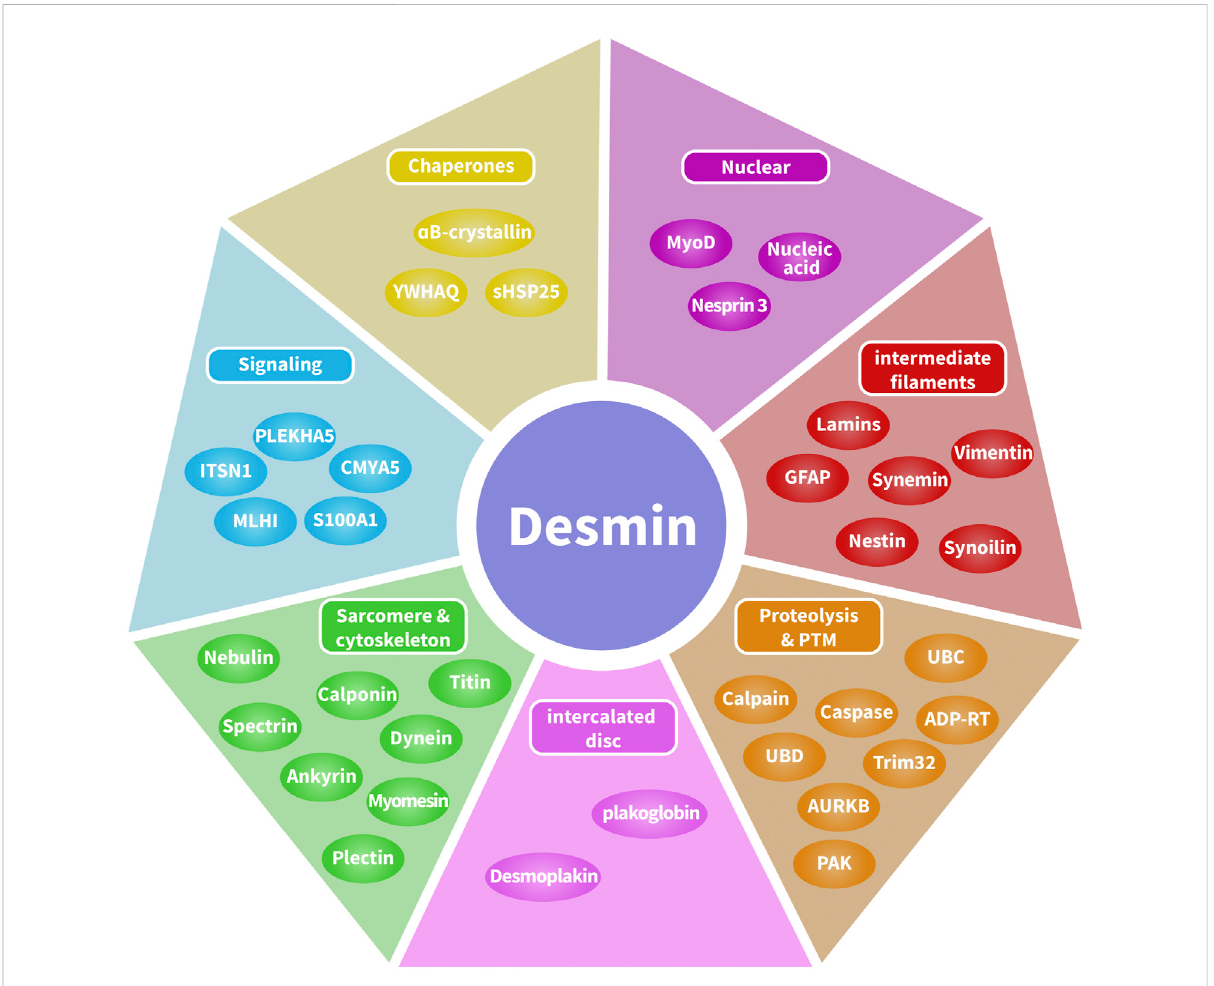
FIGURE 2 Desmin interactome map. Desmin-associated proteins include chaperones, DNA-related proteins, intermediate fi laments, proteolysis and post-translational modi fi cations, cytolinkers bridging sarcomeres and the cytoskeleton, and cellular signaling. Desmin-associated proteins are localized in multiple compartments, including costameres, contractile apparatus, intercalated discs, lysosomes, mitochondria, and the